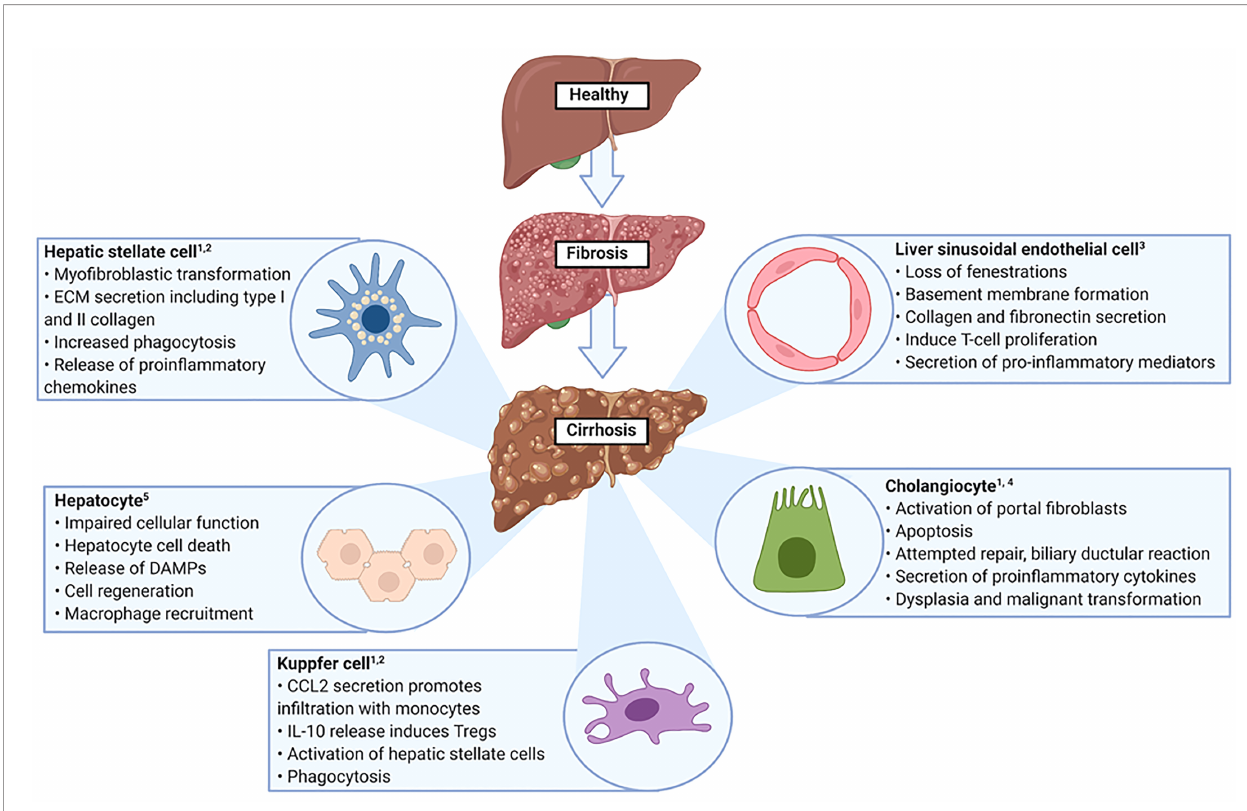
FIGURE 2 | Altered cellular function in liver cirrhosis. ECM, Extracellular matrix; DAMPs, Danger associated molecular patterns. 1. Yang F et al. Int Immunopharmacol. 2021 Aug 18;99:108051 2 . Marra F et al. Gastroenterology. 2014 Sep;147(3):577-594. 3 . Poisson J et al. J Hepatol. 2017 Jan;66(1):212-227. 4 . Matsumoto S et al. Liver. 1999 Feb;19(1):32-8 5 . Kumar S et al. Adv Drug Deliv Rev. 2021 Jul